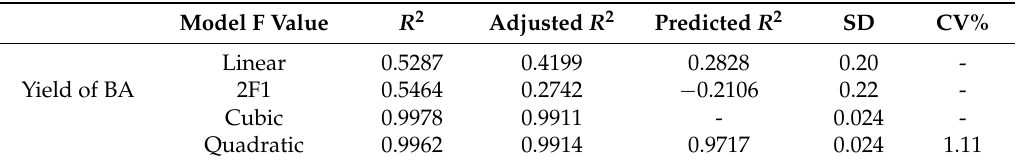
Table 6. Result of regression analysis for model and response regression equation for the final proposed model.